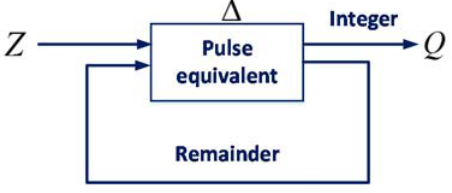
Figure 1. The quantization process.